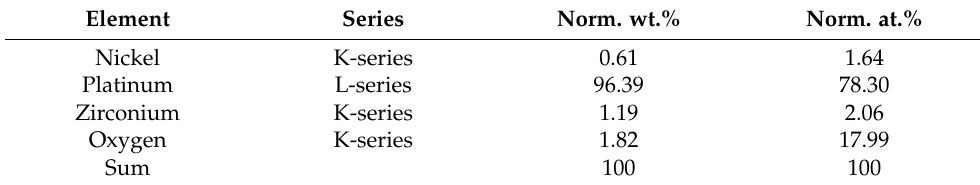
Table 4. Chemical composition of Pt agglomerate (sample 9 ).